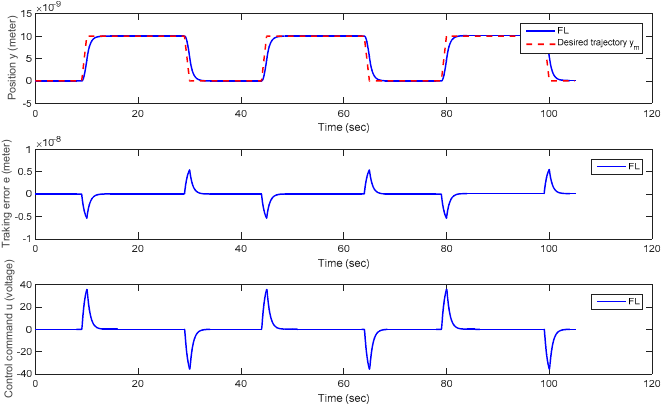
Figure 10. Plots of the positioning history y , positioning error e, and control command u versus time for Trajectory 1 (a square trajectory).